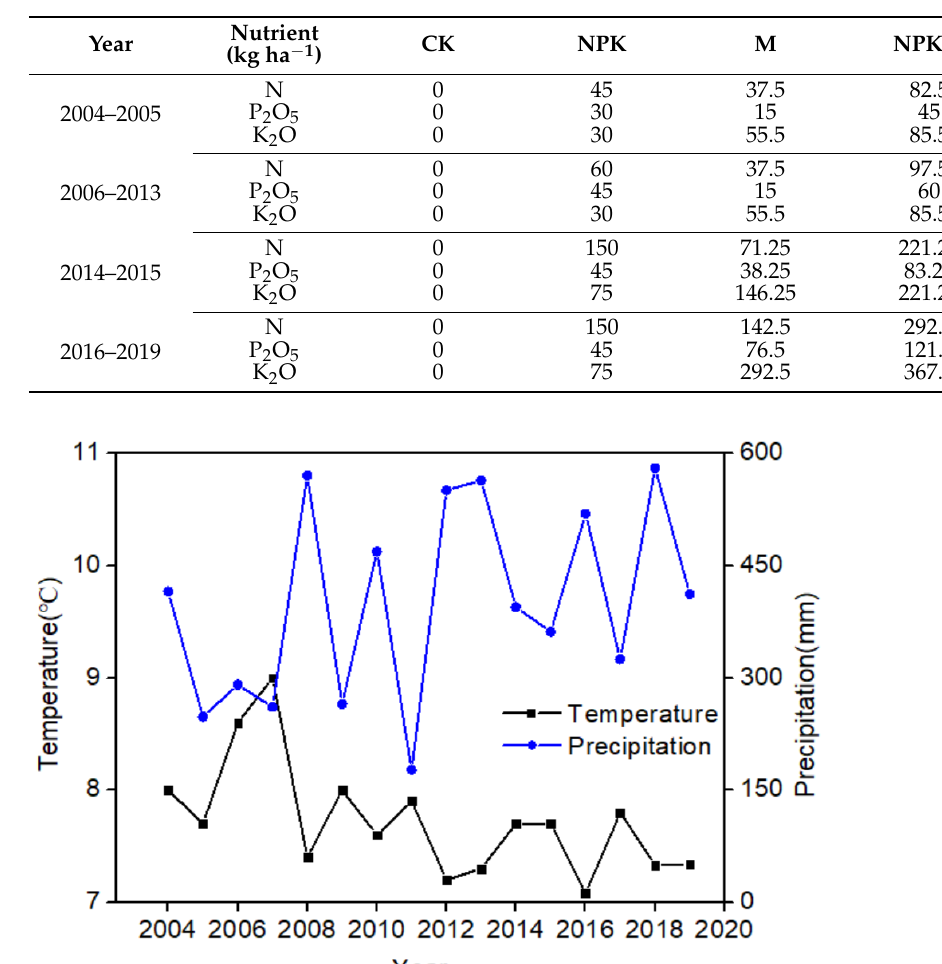
Figure A1. The annual temperature and precipitation of Wuchuan station.